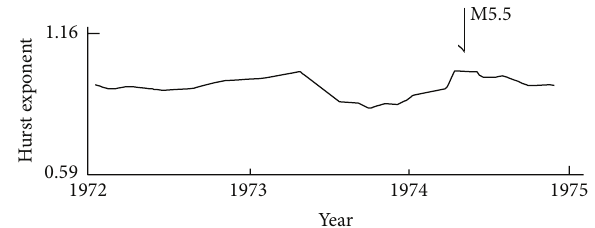
Figure 7: The temporal variation of Hurst exponent before and after the 10 February 1990 Changshu earthquake (M5.1).